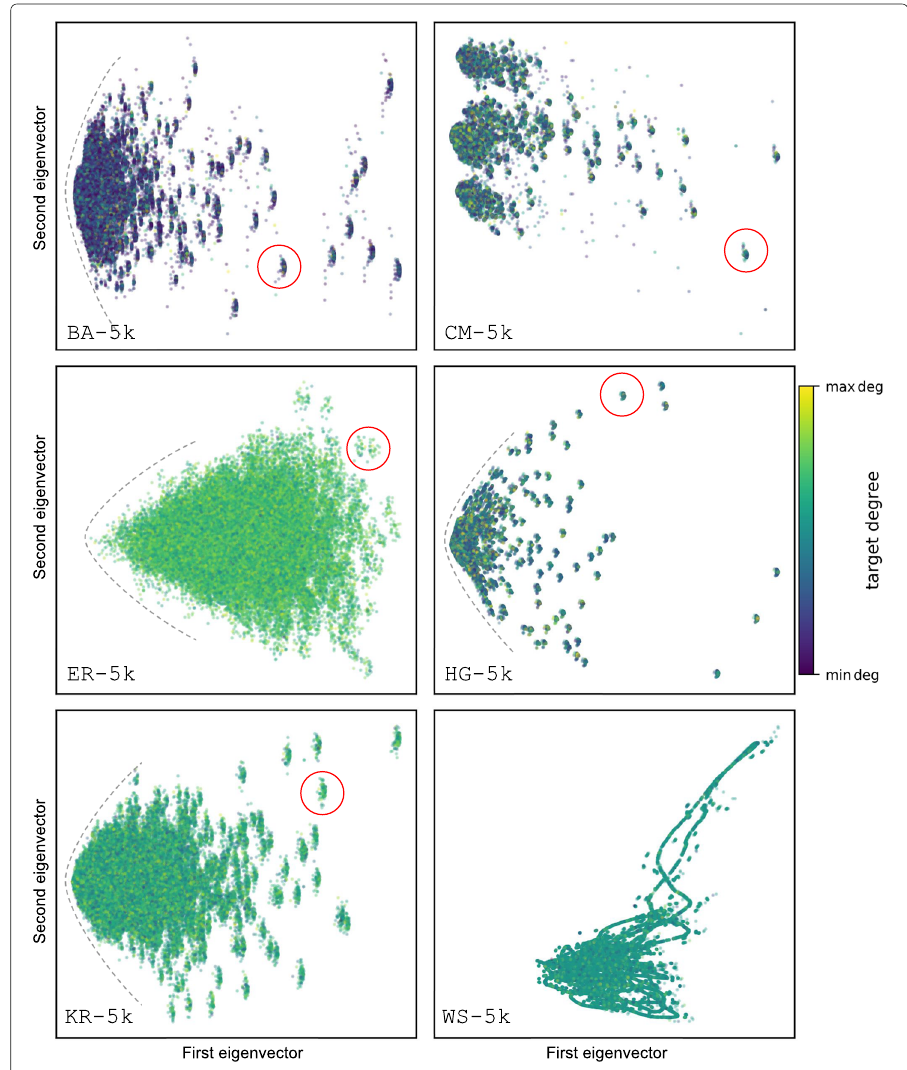
Fig. 12 NBED of example random graphs. We select one graph from each of our random data sets with n = 5,000 nodes and show its 2-dimensional NBED. Each dot corresponds to a directed edge; color corresponds to the degree of the target node. We are able to detect patterns, such as small sets of points that are separate from the rest (red circles), and boundaries that determine the regions of the plane where the points lie (gray dashed lines). See “Visualization” section for discussion and